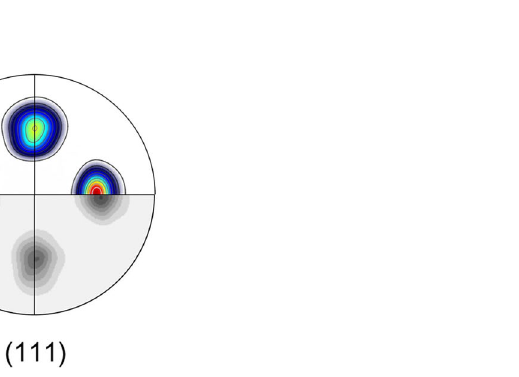
Figure 9. The ( a ) (100) and ( b ) (111) pole figures observed in 5N Al after t -HPS rotation to 2 π (bottom), by − 1 10 } <110> texture pole figure with a spreading of comparison to those estimated (top) for the {